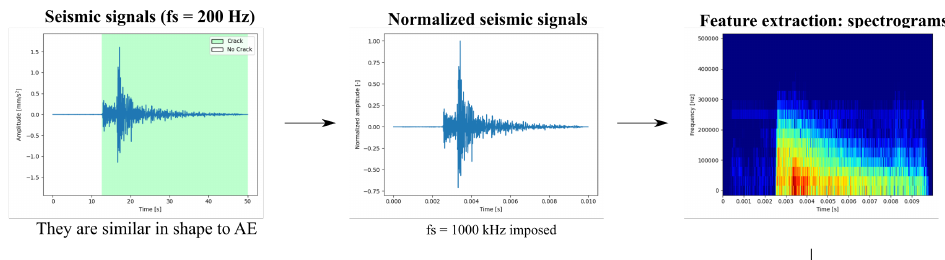
Figure 4. In the view of supervised learning, the input data are labeled in the following way: the ‘ no crack ’ label is assigned from 0 until the onset time, while the ‘ crack ’ label is assigned from the onset time until the duration of the signal is covered.